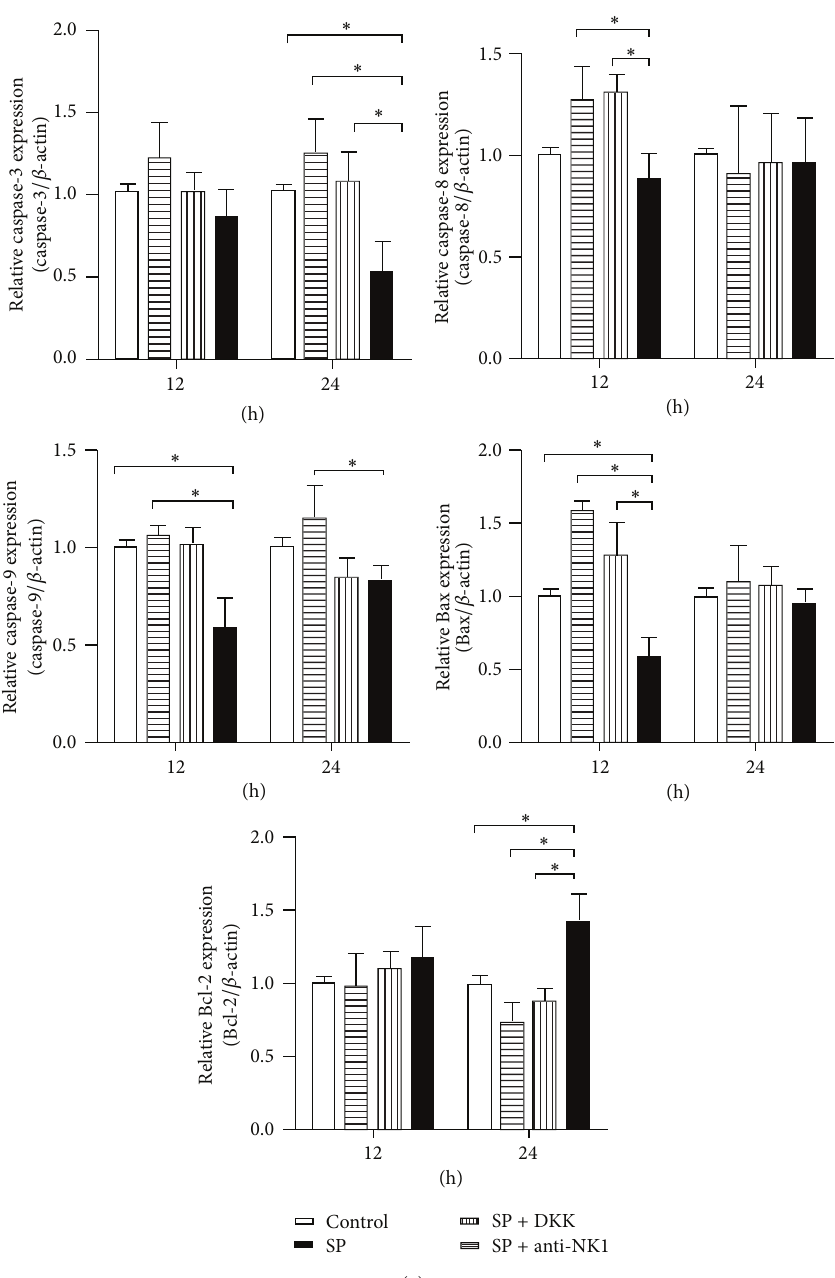
Figure 2: Effect of SP on apoptotic changes in BMSCs. MTT assays and DAPI staining were used to quantify cell viability and to detect nuclear changes. A trend of SP reduction of SD-induced apoptotic cell death was observed from the MTT assays, although SP did not exhibit a comprehensively significant prevention in BMSCs (a). Although the concentrations ranging from 10 −8 to 10 −12 mol/L all exhibited a protective trend, only 10 −10 mol/L SP exhibited a significant difference in comparison to the control group in BMSCs after 24 h of SD. Images of DAPI staining were taken 24 h after treatment and indicate that the nuclear condensation and integrity changes of BMSCs were reduced by SP (b). Arrows mark shrunken nuclei that indicate apoptotic cells. The flow cytometric analysis of Annexin V-FITC showed the protective trend of 10 −10 mol/LSPfunctionat24 hSDtreatment(c).Multipleimagesillustratethepresenceofcleavedcaspase-3inBMSCscontrolcellsandincells subjected to 24h SD or SD plus SP treatment. The red immunostaining of cleaved caspase-3 suggested a decrease in caspase-3-positive cells under SP treatment (d). Caspase-3 activation was quantified using Western blot analysis in the concentration manner (e) or combined with the treatment of DDK or NK-1 antagonist (f); a significant reduction in caspase-3 mRNA is indicated by qPCR (g) after 24 h of SD in BMSCs. Also, the mRNA levels of the apoptotic molecules Bcl-2, Bax, caspase-8, and caspase-9 were analyzed using qPCR in BMSCs (g). Although a clear decrease in Bax expression was not observed, the ratio of Bcl-2 to Bax was increased due to SP promotion of Bcl-2 expression. Caspase-8 expression was essentially identical between the SP group and the control group, and caspase-9 expression was reduced by SP